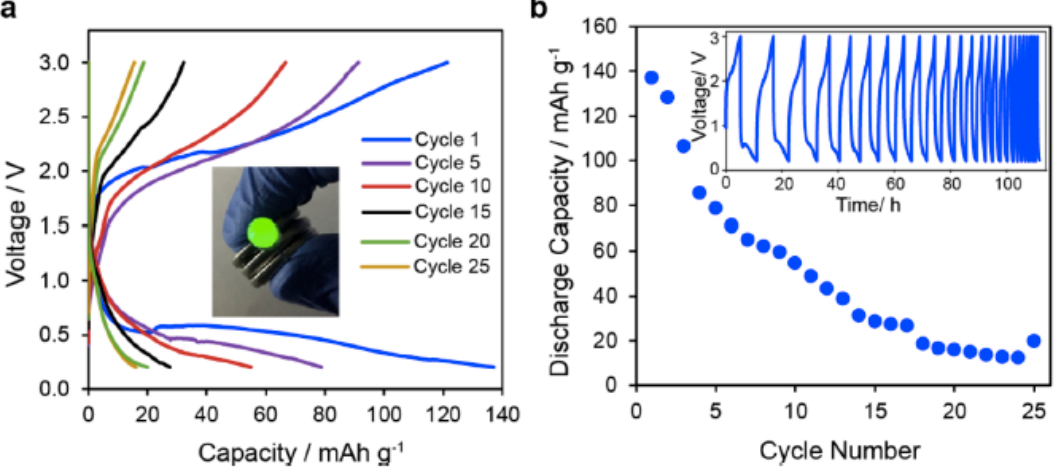
Figure 6. Preliminary battery operation using the IL–GPE in a Ca 3 Co 4 O 9 –V 2 O 5 full cell. ( a ) Galvano- static charge and discharge curves, attaining discharge capacities reaching 140 mAh/g in the first cycle. The inset shows a stack of three–coin cells powering a small green LED. ( b ) Plot of discharge capacity vs. cycle number. The inset shows charge–discharge voltage over 25 cycles. Reprinted with permission from [40].